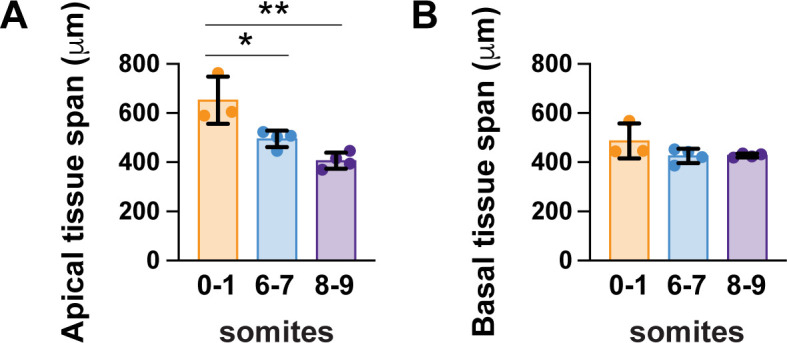
The cranial neural plate transitions from convex to concave during elevation.(A) The apical span of the cranial neural plate decreases significantly during elevation. (B) The basal span decreases slightly but does not reach statistical significance. Apical and basal spans were measured from one border to the other in the midbrain neural plate, encompassing midline and lateral cells. A single value was obtained for each embryo and the mean ± SD between embryos is shown, n = 3–4 embryos/stage, *p<0.05, **p<0.01 (one-way ANOVA test). See Supplementary file 1 for n and p values.